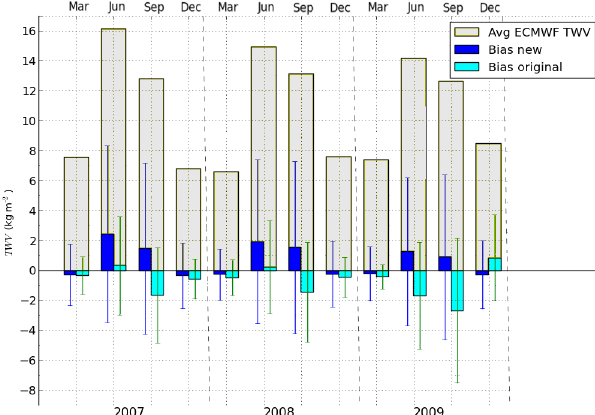
Figure 9. New AMSU-B TWV retrieval vs. ECMWF TWV. The spatial domain is the full valid domain of the new algorithm. The entire test data set of 12 months over 3 years is represented. The black line is the identity line, while the red line represents the data linear regression and the two green lines show the 15 (kgm − 2 ) sat- uration limit of the extended-range TWV retrieval module.